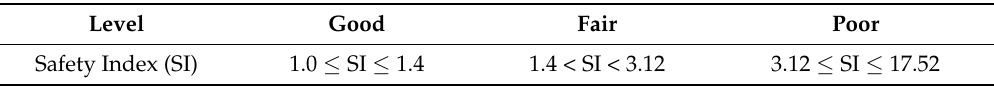
Table 8. Level of safety associated to Safety Index (SI)